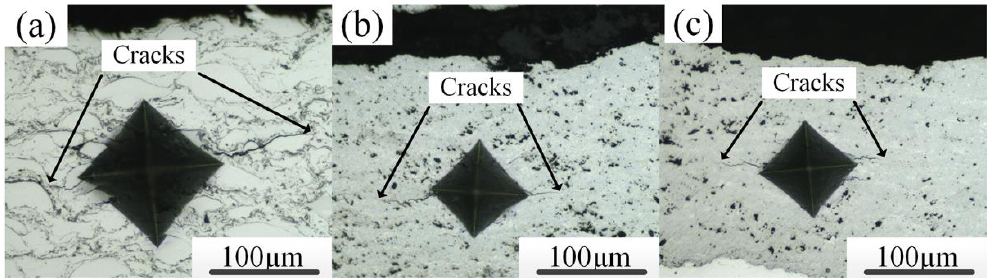
Figure 5. The microhardness and fracture toughness of the coatings.